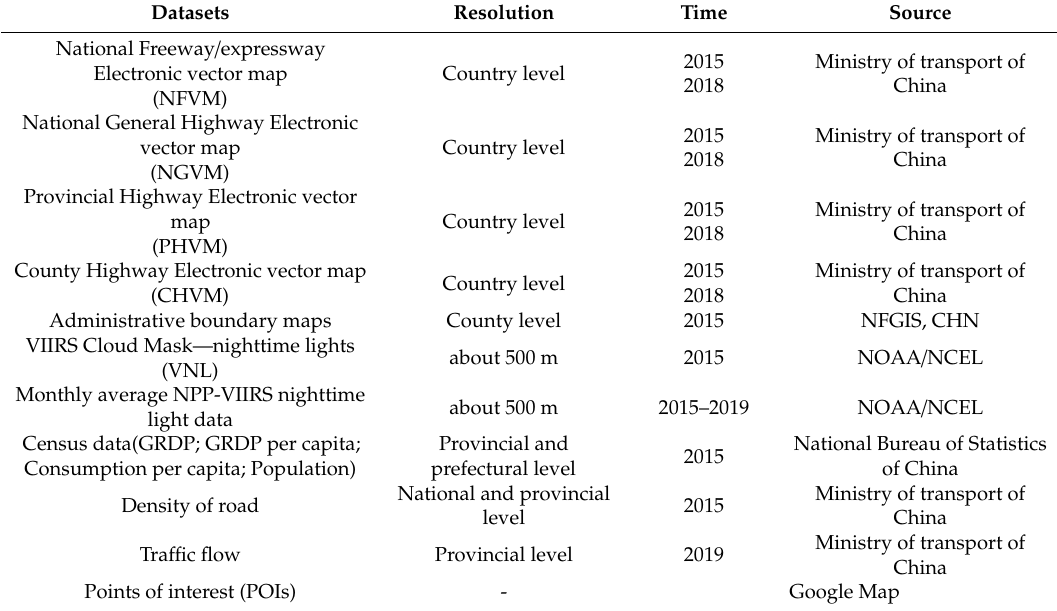
Table 1. List of dataset and source in the